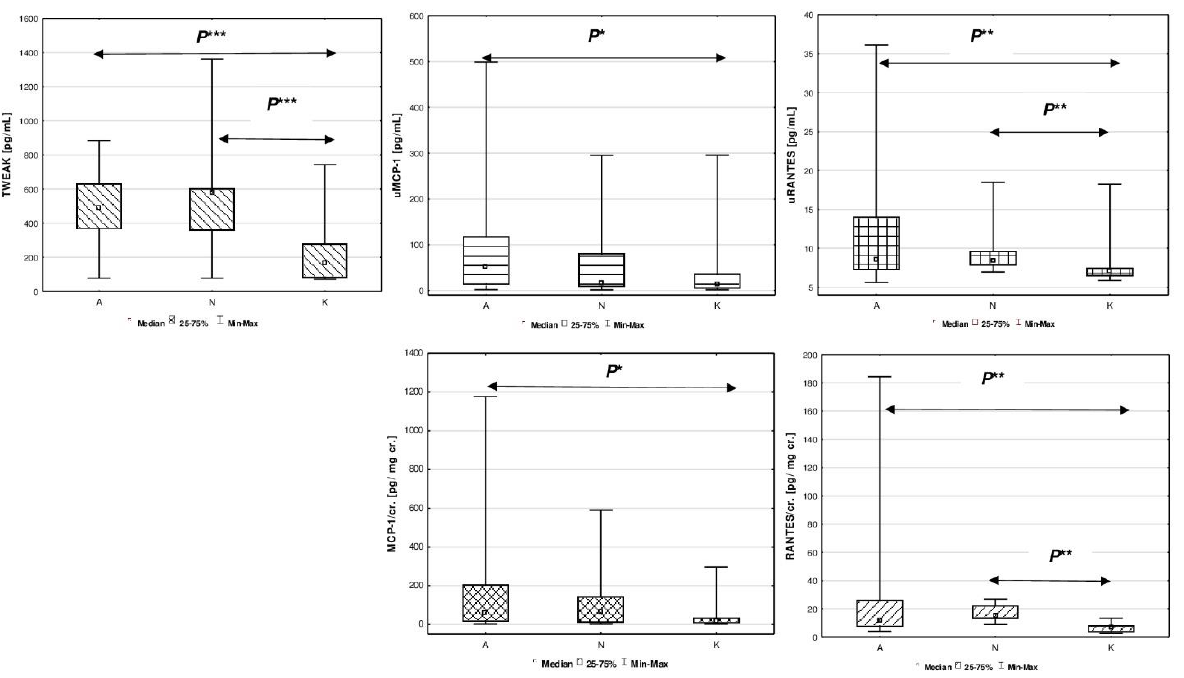
Figure 1. Comparison of estimated biomarkers between studied children with congenital A, acquired solitary functioning kidney N and the reference K groups. Figure legend: P * p < 0.05, P ** p < 0.01, P *** p < 0.0001. ( A ) TWEAK [pg/mL]; ( B ) uMCP-1 [pg/mL]; ( C ) uRANTES [pg/mL]; ( D ) MCP-1/cr. [pg/mg cr.]; ( E ) RANTES/cr. [pg/mg